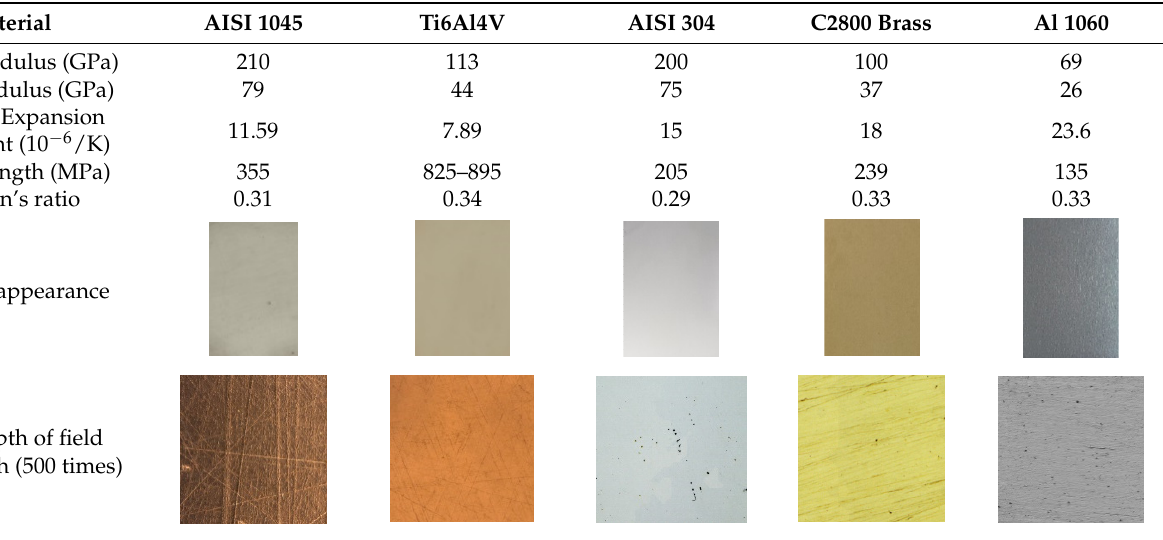
Table 1. Substrate material characteristics, macroscopic features and microscopic features.